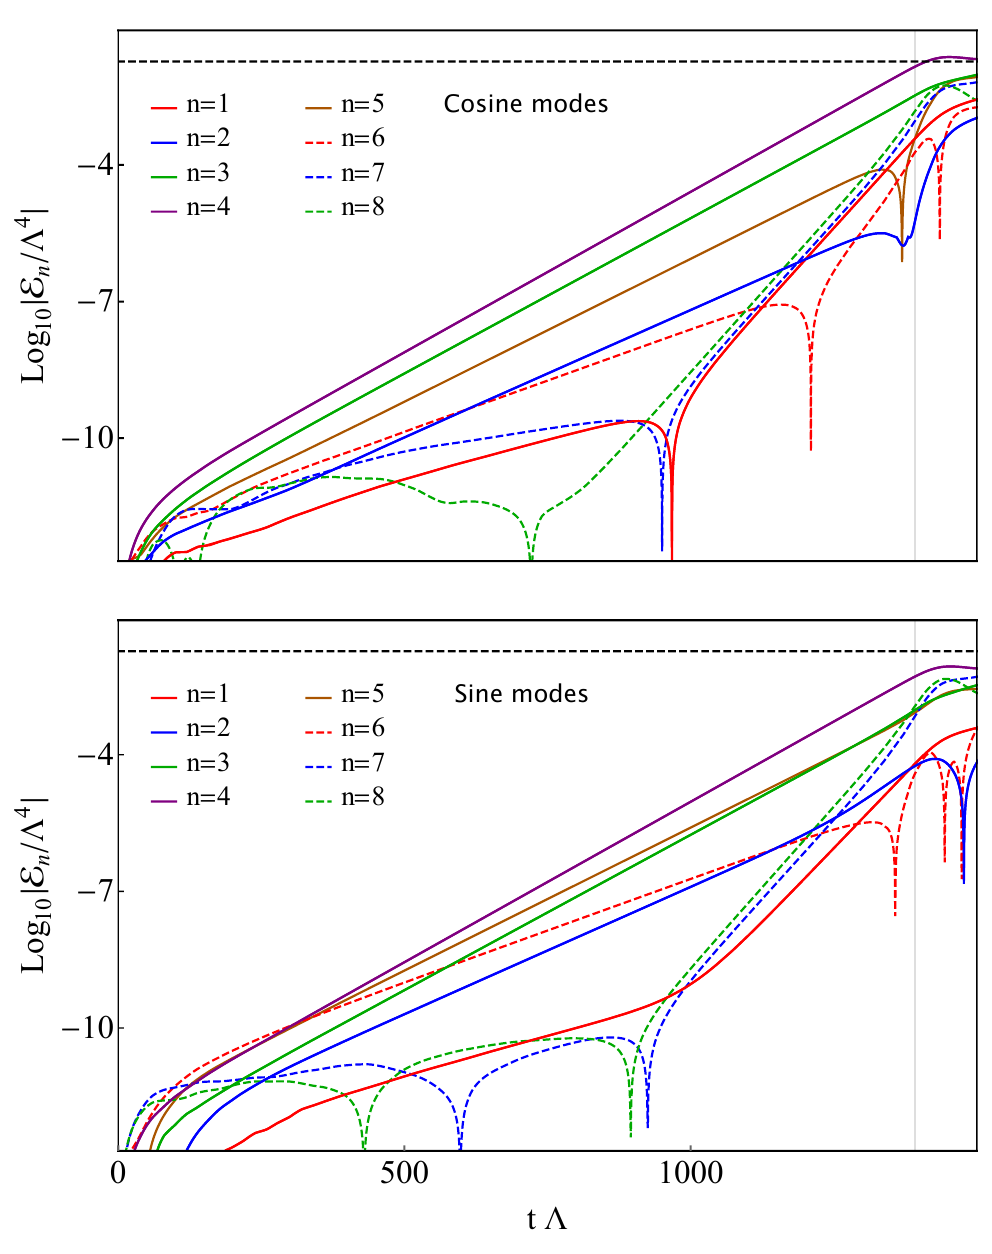
Figure 6 . Time evolution of some cosine (top) and sine (bottom) Fourier modes of the energy density shown in (cid:12)gure 4(right). The dashed horizontal lines at the top indicate the average energy density or, equivalently, the n = 0, constant mode. The grey vertical lines at t (cid:3) = 1392 indicate the end of the linear regime. A snapshot of the energy pro(cid:12)le at this time is shown in (cid:12)gure 8(right) in solid blue.